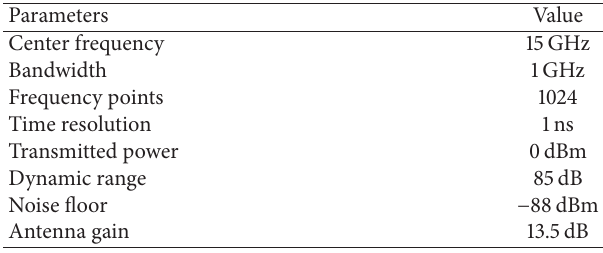
Table 2: Measurement parameters.